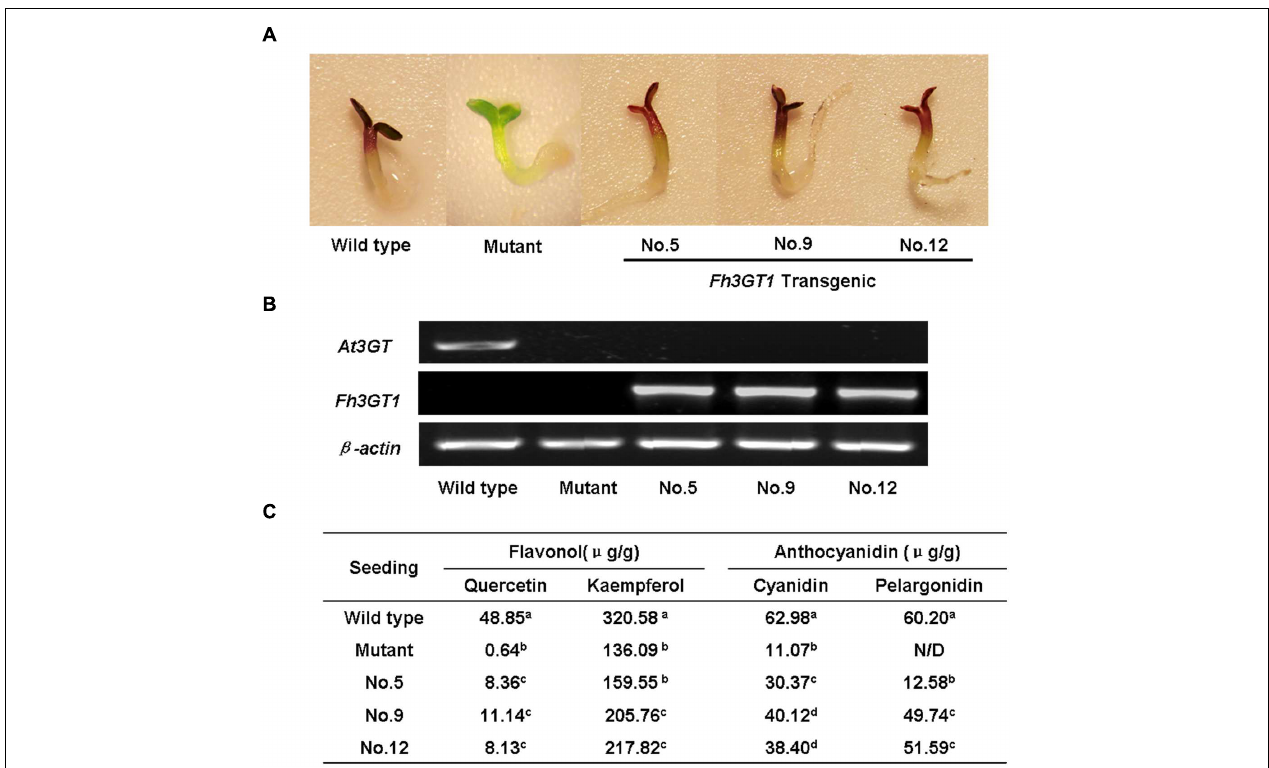
FIGURE 6 | Complementation of the pigmentation of Arabidopsis mutant seedlings with Fh3GT1 gene. (A) Phenotypes of wild-type, mutant ( UGT78D2 ) and transgenic Arabidopsis seedlings. (B) Expressional analysis of the At3GT and Fh3GT1 gene by reverse transcription polymerase chain reaction in wild-type, mutant and transgenic lines. (C) Contents of anthocyanins and flavonols in Arabidopsis seedlings. Data correspond to means of three biological replicates. Means with different letters within the same column are significantly different at the 0.01 level of probability. N/D, not detected.